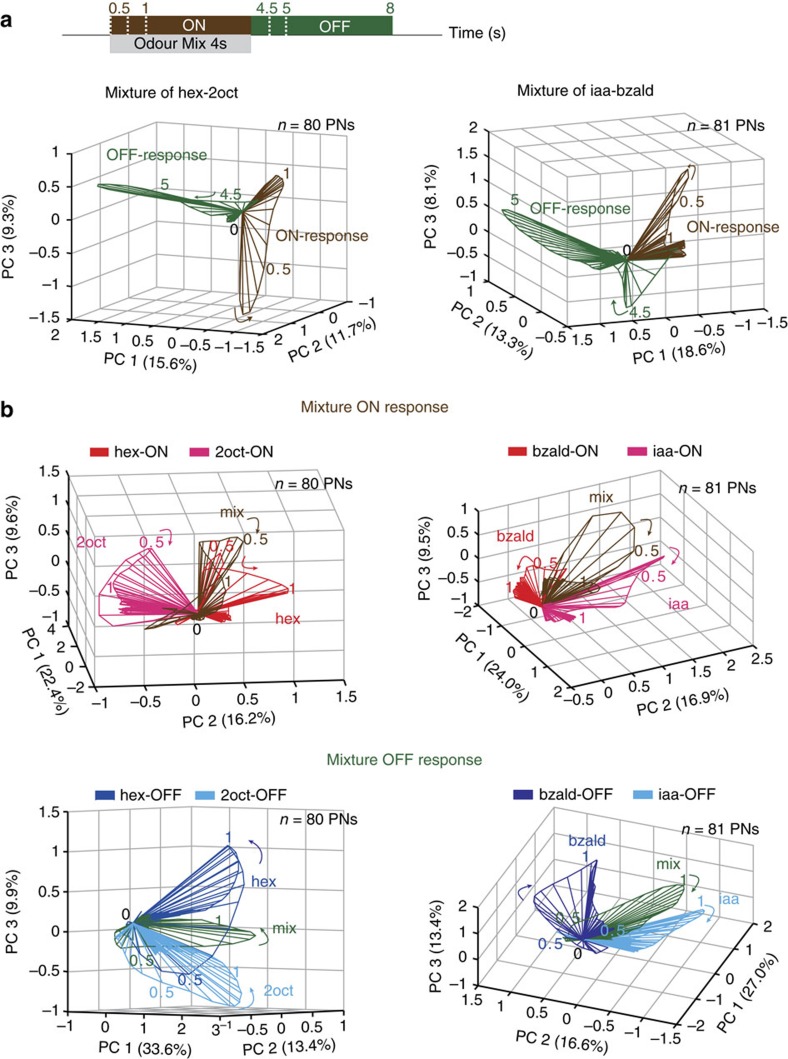
Encoding of binary mixtures.(a) Odour trajectories evoked by a binary mixture during ON and OFF epochs are shown after PCA dimensionality reduction. The number of neurons (n) used for this analysis and the percentage of variance are shown in each plot. Numbers near response trajectories indicate time in seconds since odour onset. (b) Odour trajectories evoked by a binary mixture and its two components are shown after PCA dimensionality reduction. Note, ON responses and OFF responses are compared separately in these plots. Same convention is used as in a.